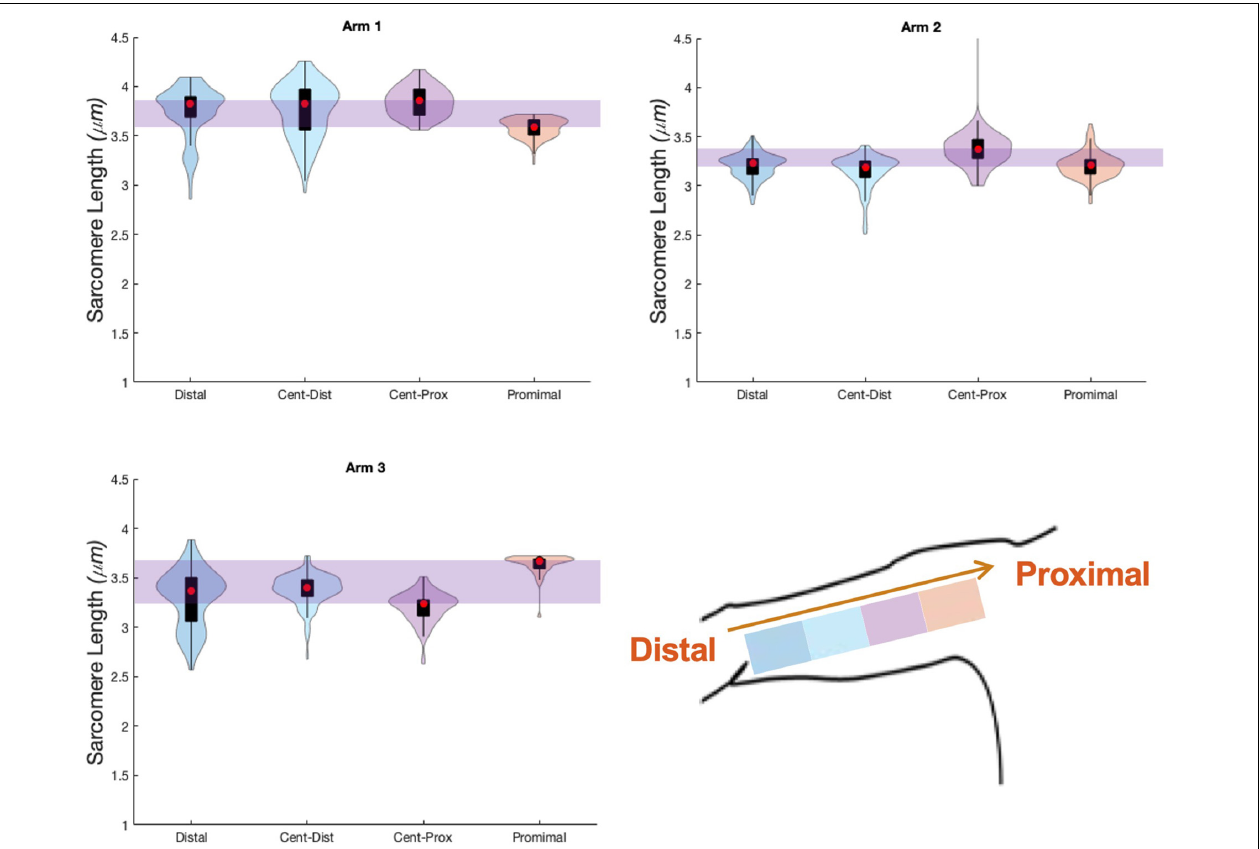
FIGURE 6 | Violin plots for 4 locations, and three arms showing median of data (red circle), interquartile range (black box plot), and probability density of data at each location (shaded violin shape). Arm 2 (right, dominant) and Arm 3 (left, non-dominant) are from a single